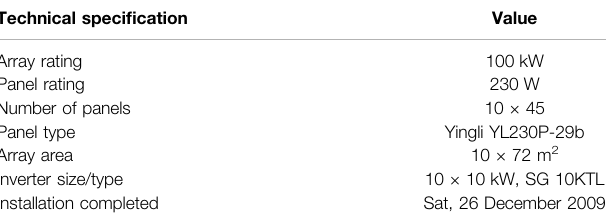
TABLE 5 | Technical speci fi cations of the Taiyangshan power system. Technical speci fi cation